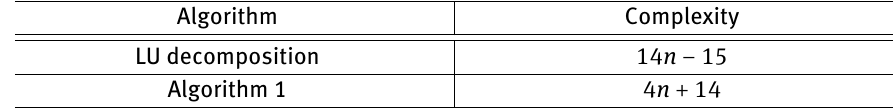
Table 1: The complexity comparison of computing determinant for different